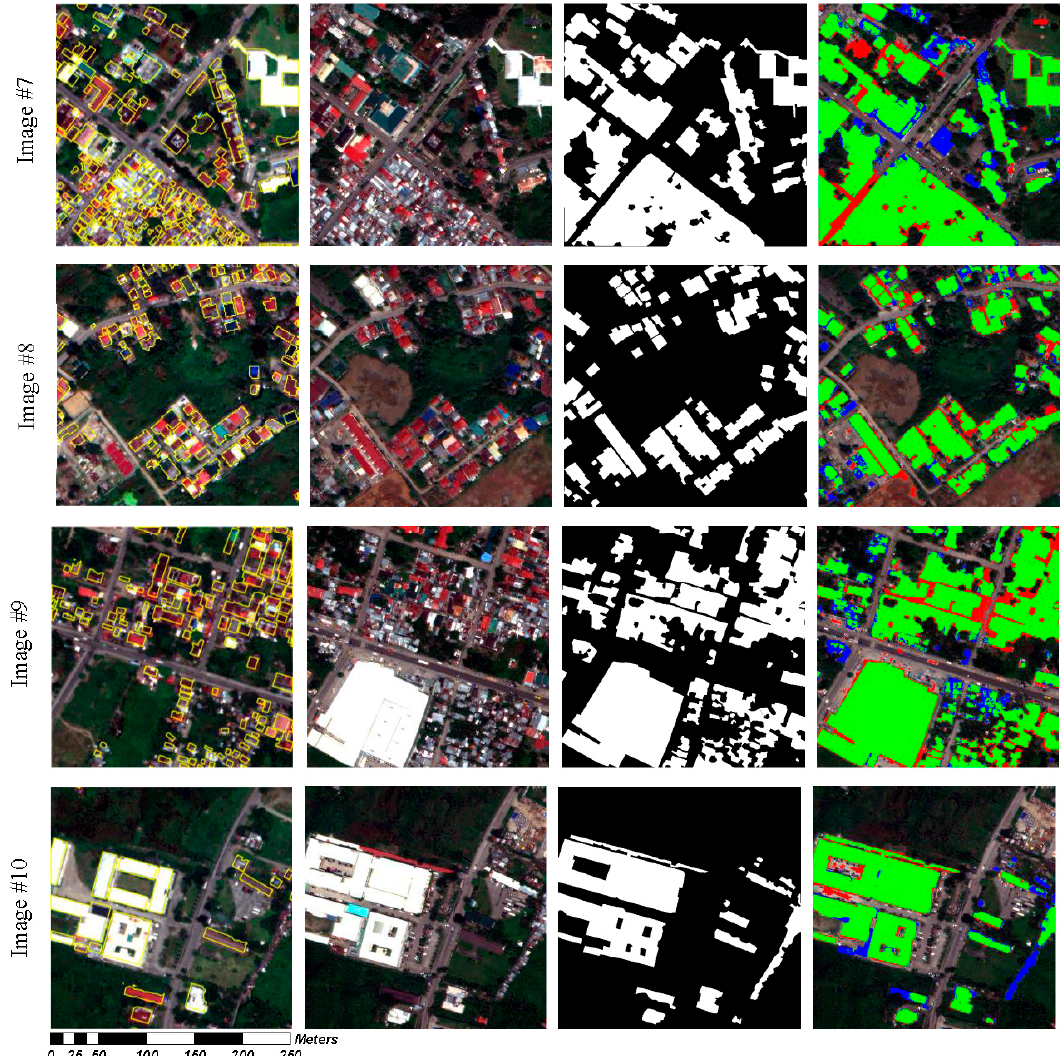
Figure 6. The results of the proposed method, test images, and pre-disaster images with OSM building boundaries (yellow). Column A: Pre-disaster (8 months before Haiyan) images with OSM building boundaries in yellow. Column B, Images #1–5 were taken 3 days after Haiyan and Images #6–10 were taken 4 years after Haiyan. Column C: the reference image for buildings, in which white and black colors represent the building and background pixels, respectively. Column D: detected buildings for test images. Green, red, and blue represent TP, FP, and FN, respectively.